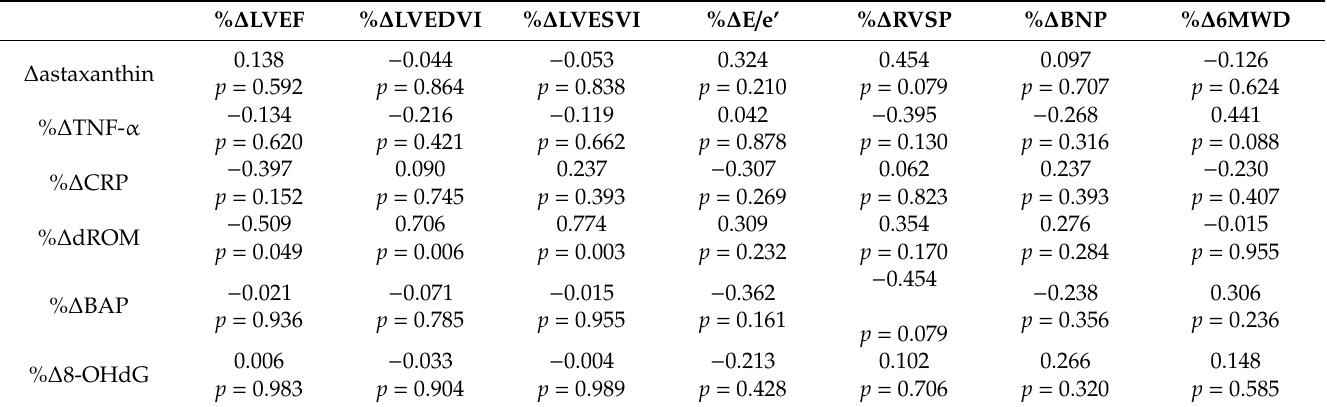
Table 3. Correlation coe ffi cients and p -values for relationships between changes in astaxanthin level, inflammatory and oxidative stress markers, and cardiac functions from baseline to 3